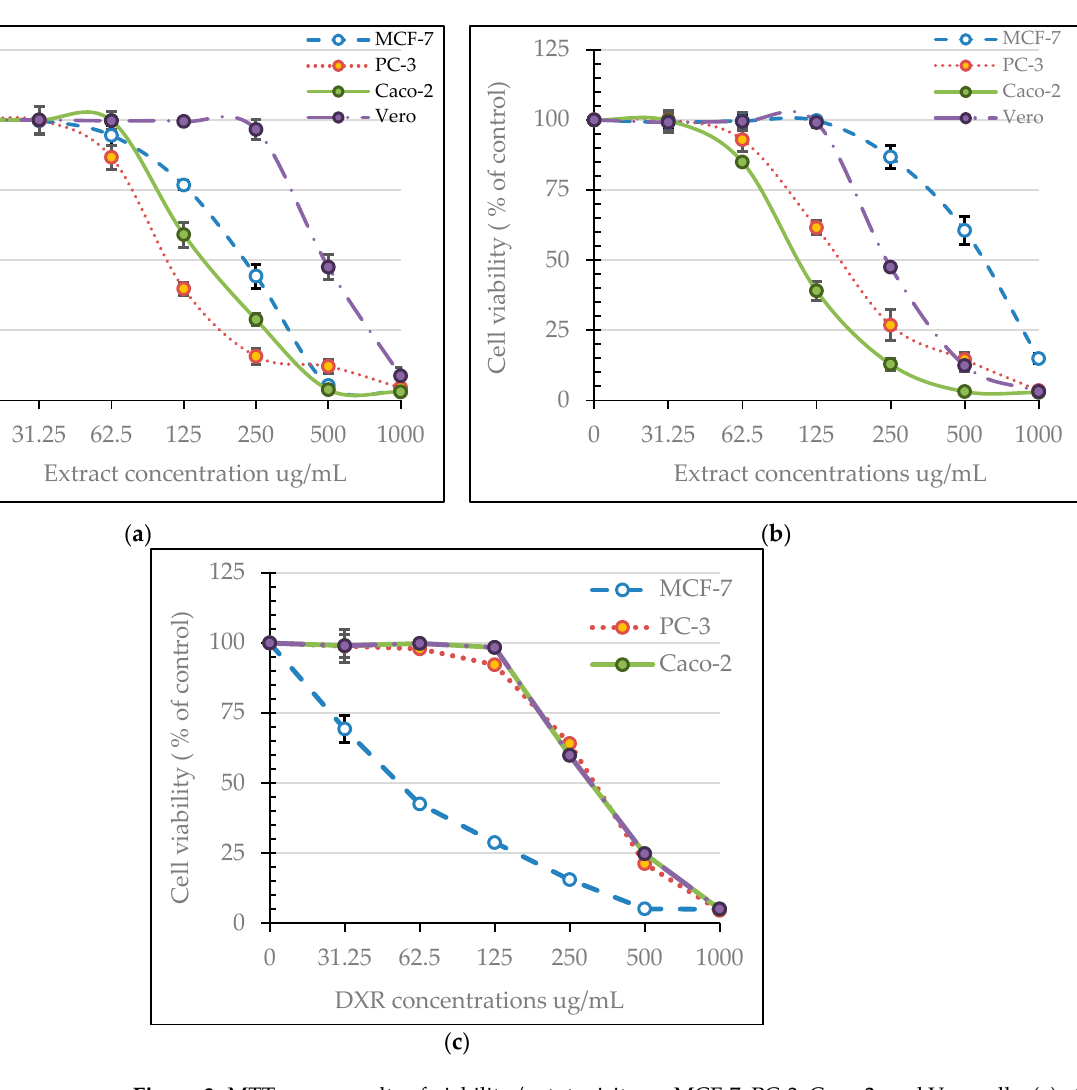
Figure 3. MTT assay results of viability/cytotoxicity on MCF-7, PC-3, Caco-2, and Vero cells: ( a ) effect of the methanolic extracts from neem fruit mesocarp; ( b ) effect of the methanolic extracts from neem fruit epicarp; ( c ) effect of doxorubicin. Cytotoxicity levels were derived from three experiments done in triplicate. Values are represented as the mean ± SD. Table 6. IC 50 (µg/mL) and selectivity index of the methanolic extracts of neem fruit epicarp and mesocarp against different cell lines.